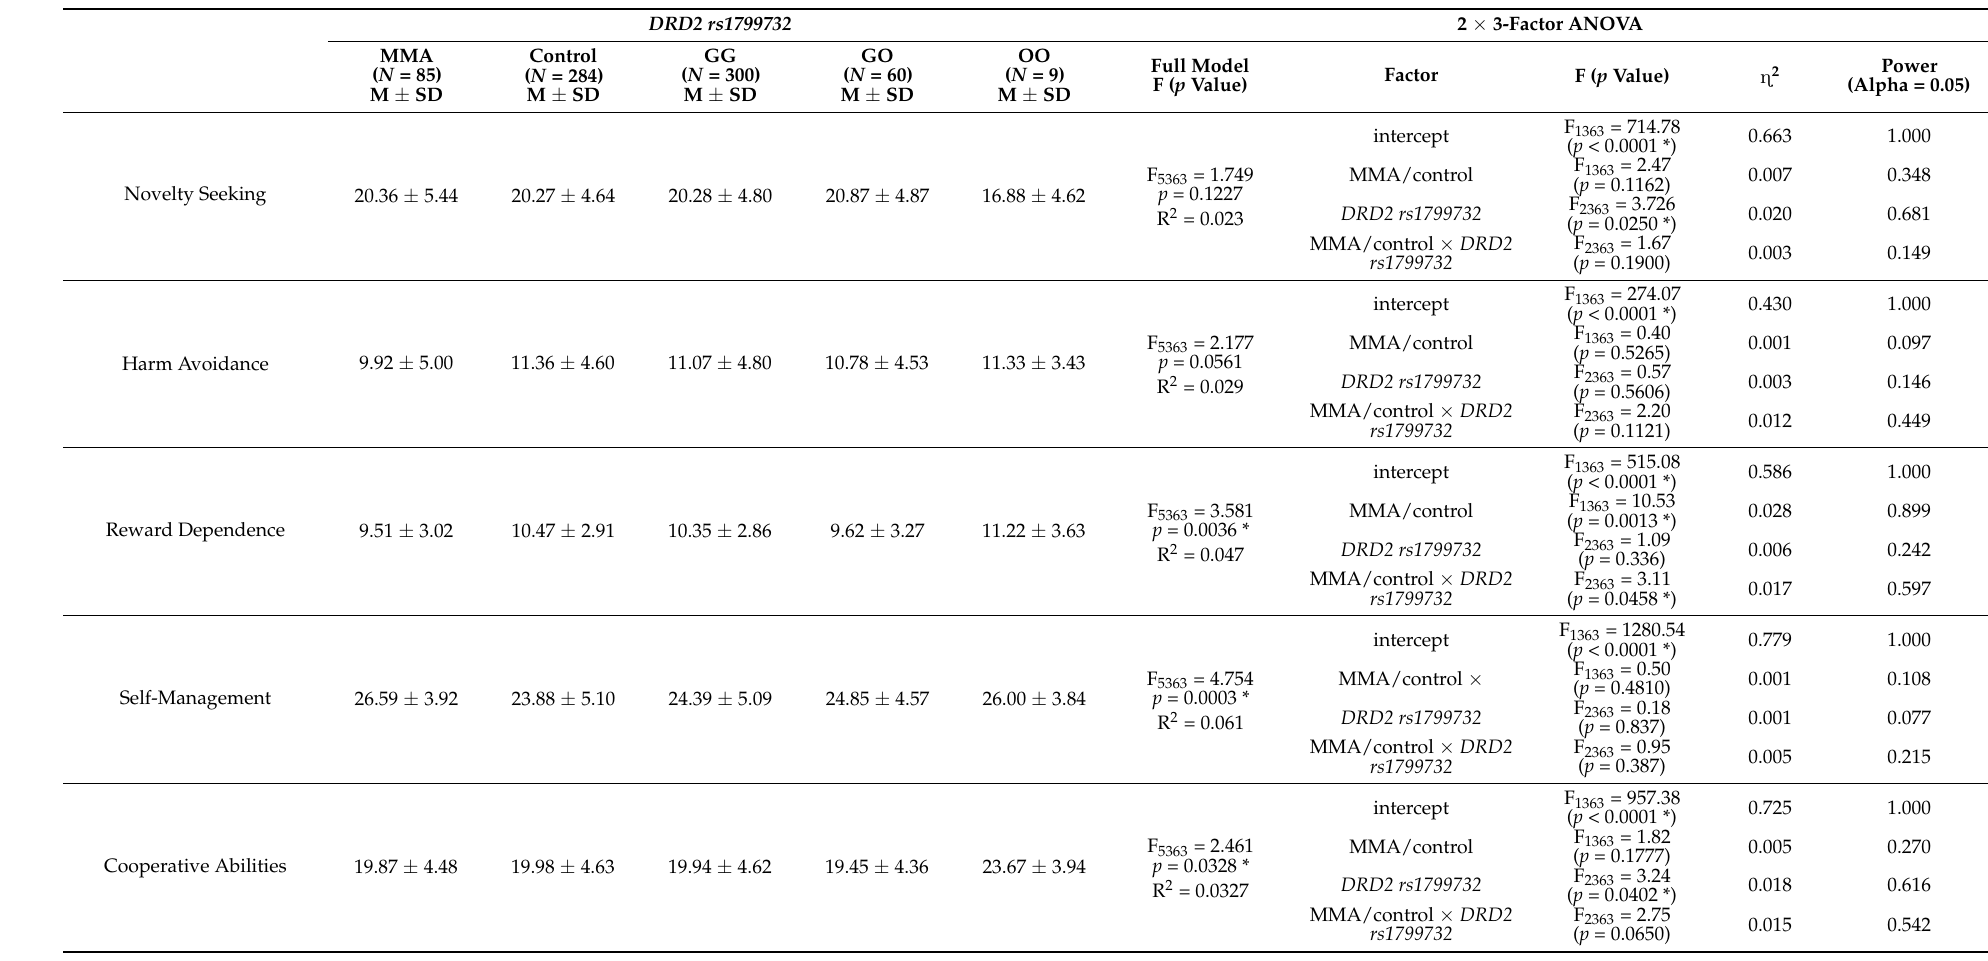
Table 5. Results of 2 × 3 factorial ANOVA for MMA subjects and controls, incorporating novelty seeking, harm avoidance, reward dependence, self-management, ability to cooperate, self-transcendence skills and DRD2 rs1799732